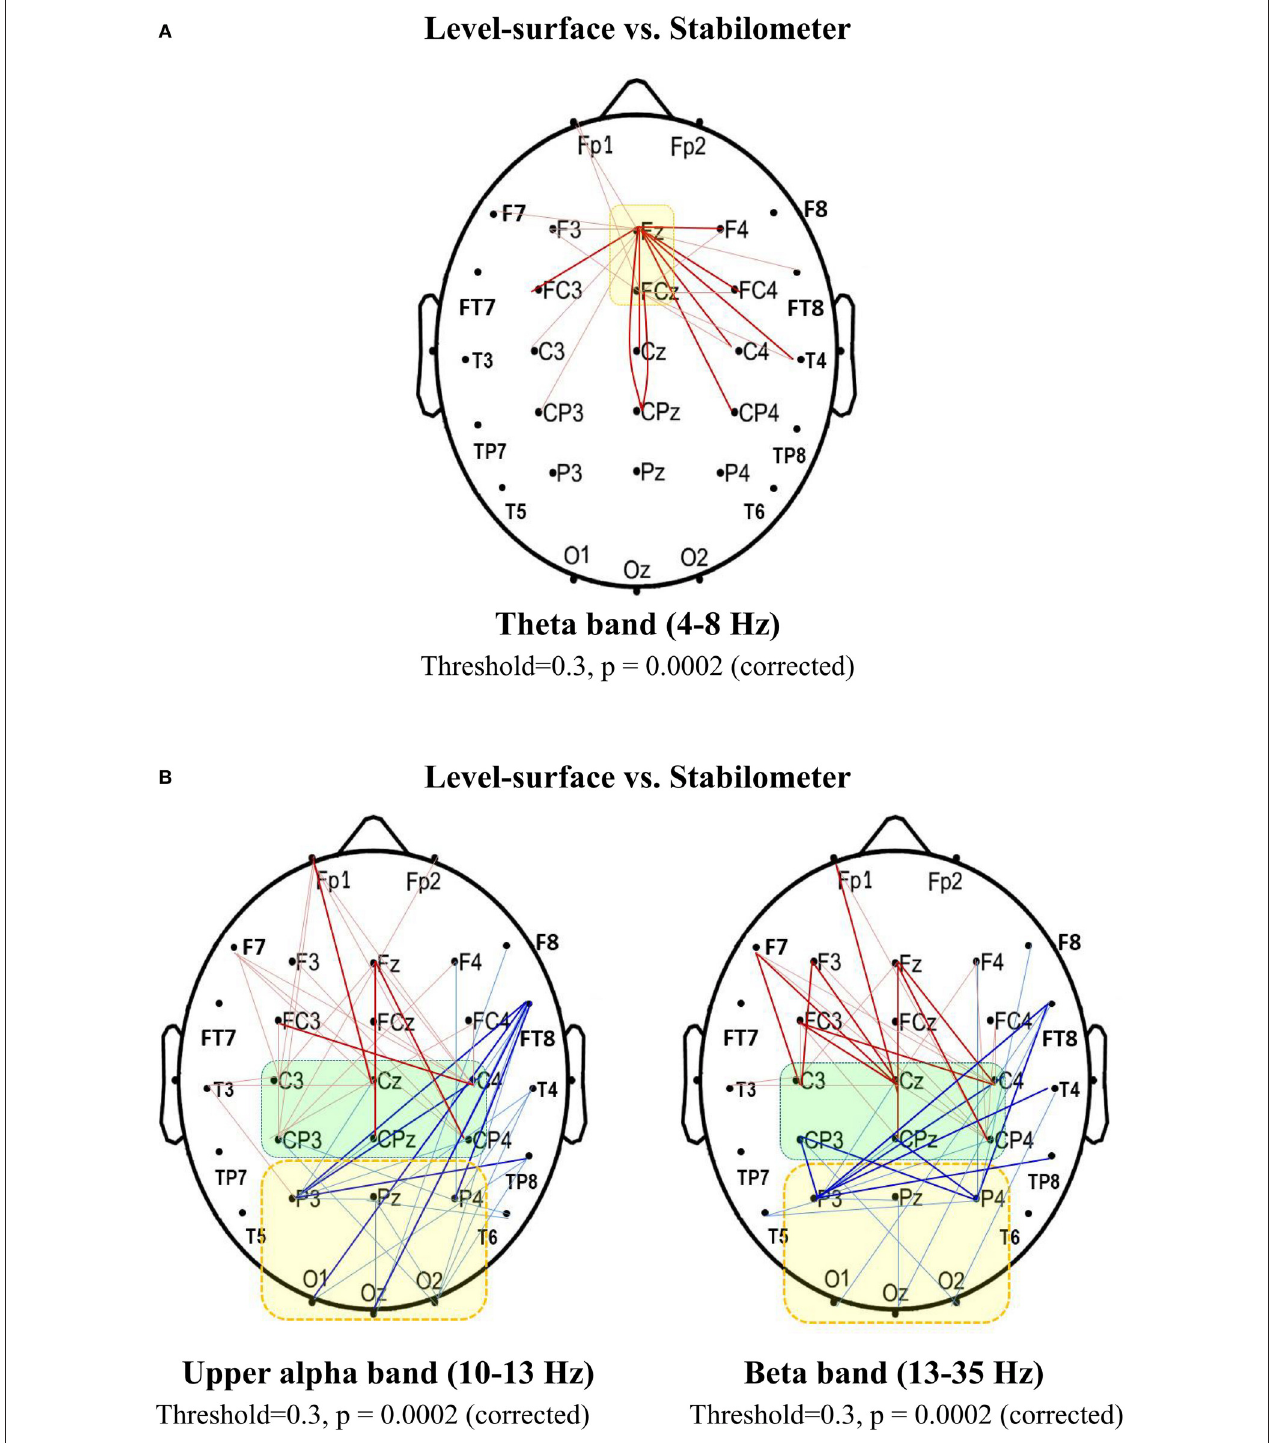
FIGURE 6 | Spectral connectivity analysis for contrasting wiring diagrams between the concurrent force-matching and postural tasks in the level-surface and stabilometer conditions (threshold value = 0.3). (A) Synchronization likelihood in the theta band (4–8Hz) that connects to the mid-frontal area (F z and FC z ). (B) Synchronization likelihood in the upper alpha (10–13Hz) and beta band (13–35Hz) of recording electrodes that connect to the sensorimotor (C 3 , C z , C 4 , CP 3 , CP z , and CP 4 ) and parietal-occipital (P 3 , P z , P 4 , P 3 , O 1 , O z , and O 2 ) areas (thin red line, stabilometer connectivity > level-surface connectivity, p < 0.05; bold red line, stabilometer connectivity of supra-threshold > level-surface connectivity of supra-threshold, p < 0.005; thin blue line, level-surface connectivity > stabilometer connectivity, p < 0.05; bold blue line, level-surface connectivity of supra-threshold > stabilometer connectivity of supra-threshold, p < 0.005).